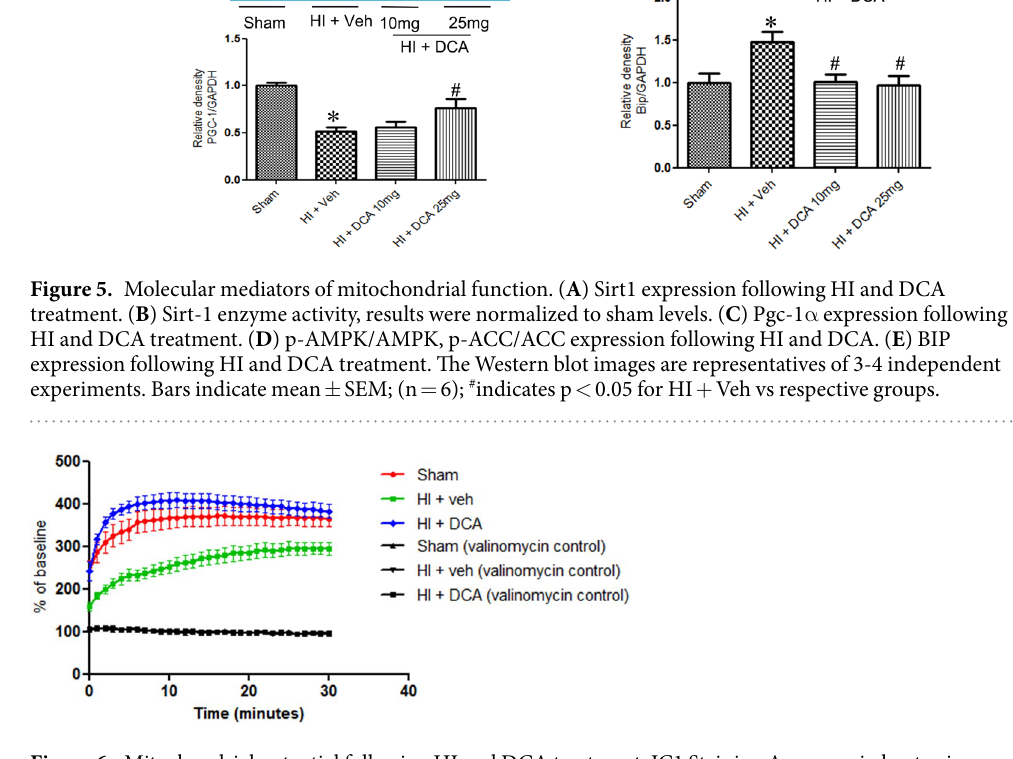
normalized hexokinase activity in DCA treated group, we did not observe a decrease in its activity from that of vehicle treated rats subjected to HI. This demonstrates that the heightened glycolytic activity continues even after DCA treatment. The JC-1 uptake assay demonstrated decreased membrane potential in the animals treated only with vehi- cle. The membrane potential in DCA treated animals, as measured by JC-1 aggregation, was similar to that in sham animals. The experiment demonstrates an overall decline in membrane potential following HI and provides further evidence for the deleterious effect of HI on mitochondria and the salutary actions of DCA in potentiat- ing mitochondrial function. These experiments demonstrate that by directly intervening on mitochondria, the outcome following HI can be significantly improved. The decompensated hemorrhagic shock model we used is